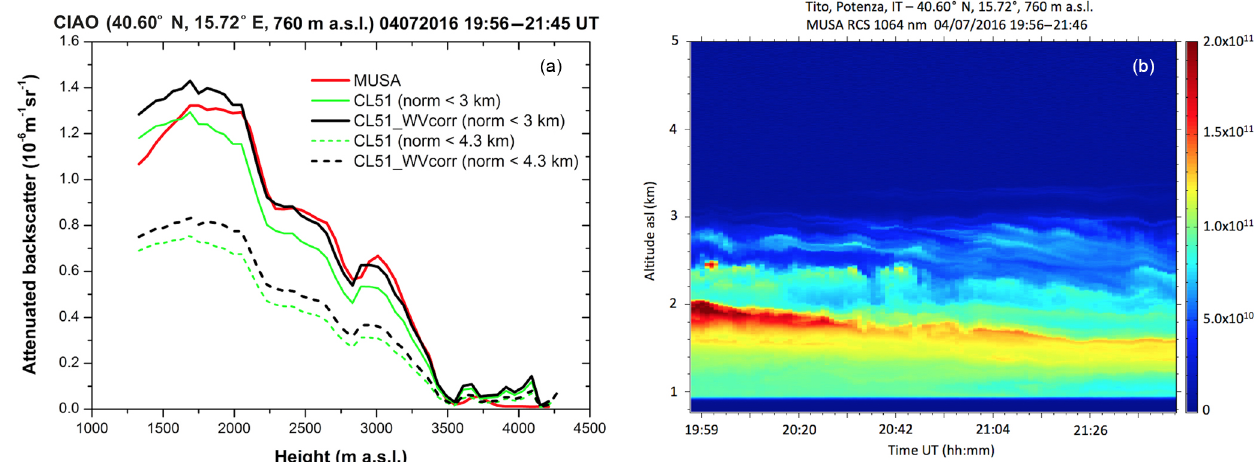
Figure 9. (a) Comparison between the attenuated backscatter vertical profiles retrieved from MUSA and CL51 on 4 July 2016 from 19:56 to 21:45UT and obtained using two different normalization ranges, the first below 3km (solid lines) and the second below 4.3km (dashed lines); both the raw calibrated profiles and the water vapor calibrated corrected profiles are shown. (b) Time series of the RCS measured with MUSA at 1064nm during the same time period used to create the average profiles in panel (a)